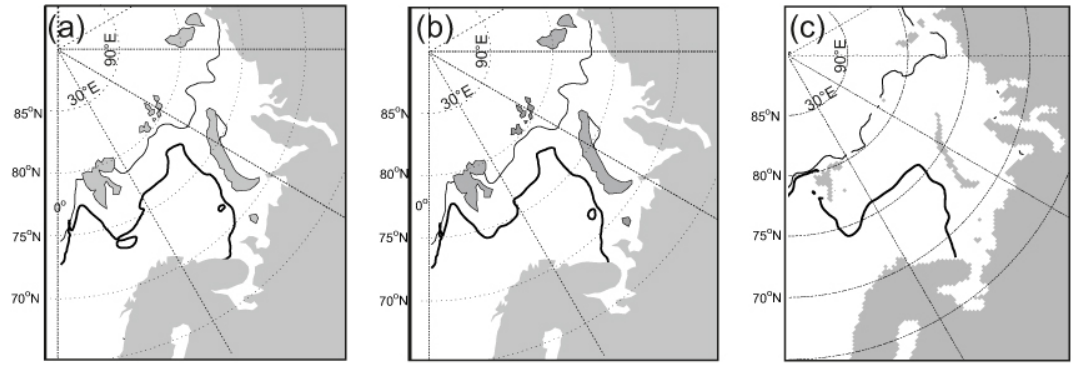
Fig. 5. Location of the ice edge when sea ice extent is at its’ maximum and minimum for (a) the control run, (b) the run including tides and (c) from remote sensing of brightness temperatures data (Cavalieri et al., 1996, updated 2008). The thin lines show the monthly mean ice edge for September 2000 and the heavy lines show the monthly mean ice edge for March 2001. The ice edge is defined as the line of 15% concentration.